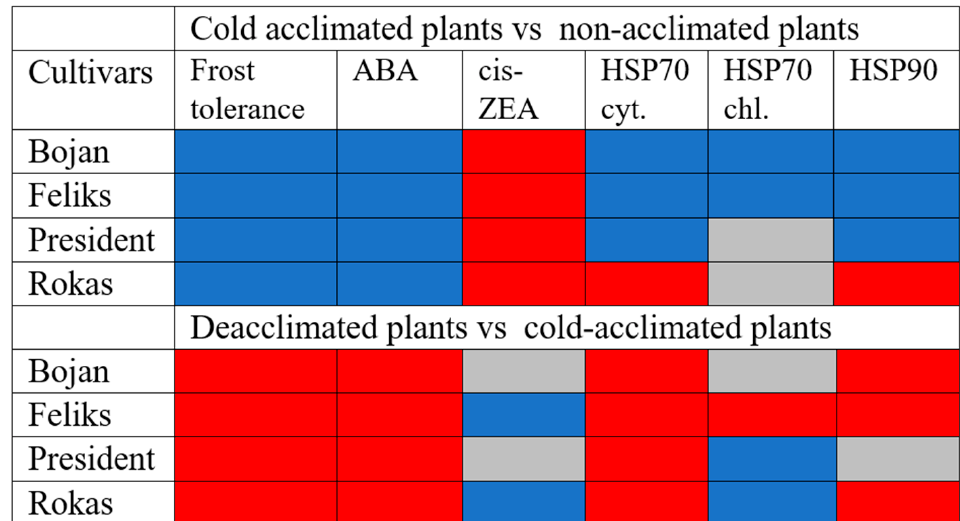
Figure 9. Directions of the changes in the frost tolerance of cold acclimated and deacclimated oilseed rape plants against the background of changes in the concentrations of ABA, cytokinin cis-ZEA, HSP70 cytoplasmic (cyt.), HSP70 chloroplastic (chl.) and HSP90. The visualization is based on the data from [3] (frost tolerance) and on Figure 1A–D, Figure 6A–D and Figure 7A–L. Blue—increase, red—decrease, grey—no